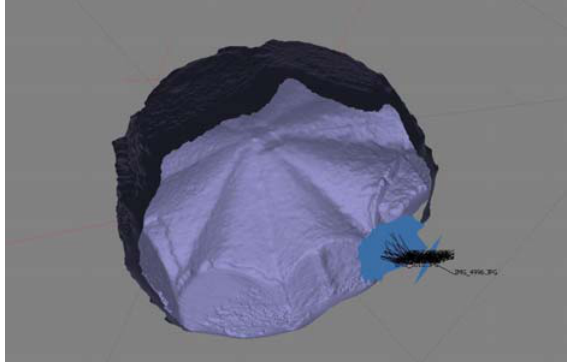
Figure 2. Oriented photographs used for the digital photogrammetric survey of the